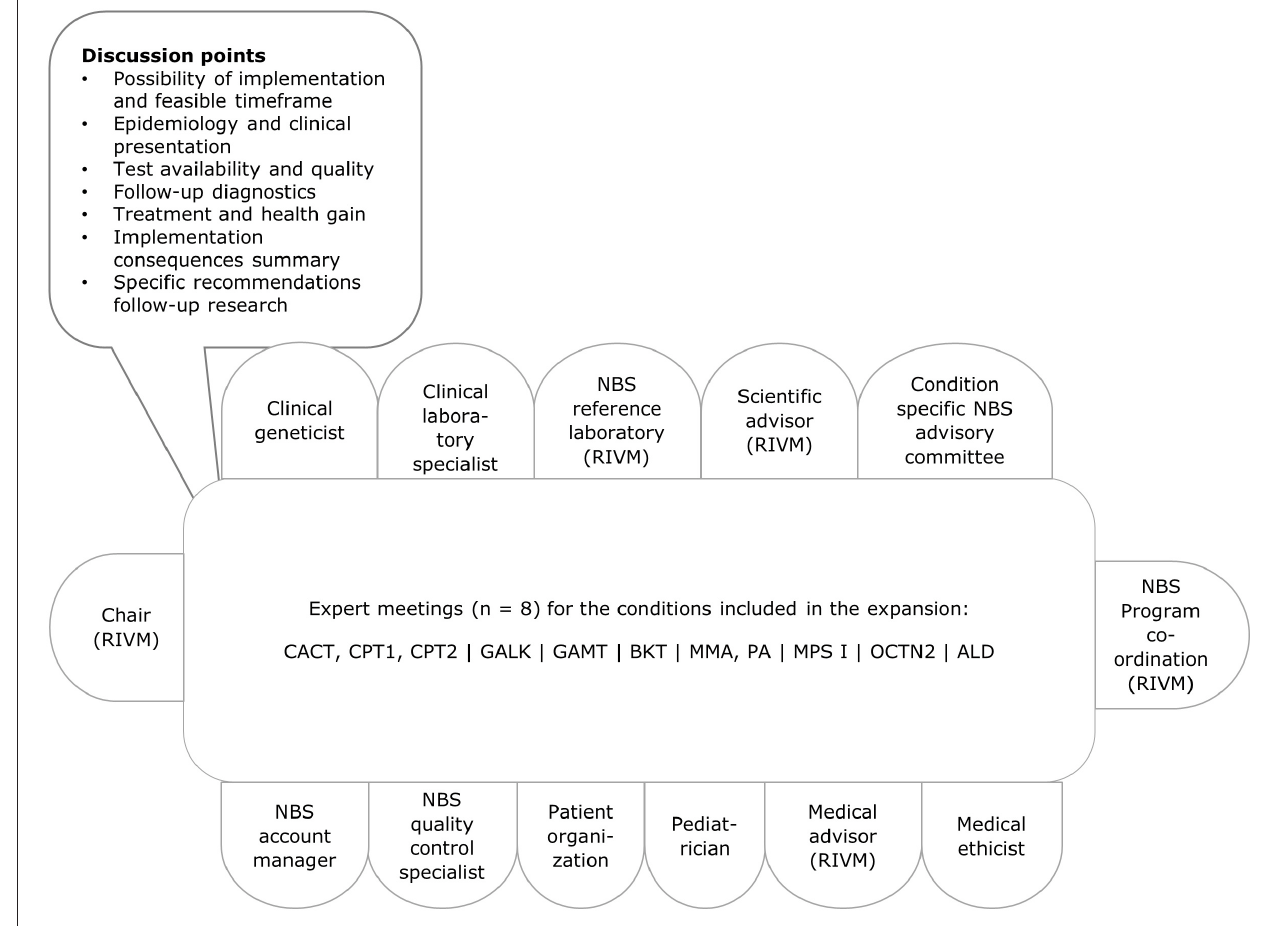
FIGURE 2 | Stakeholders involved and agenda with discussion points. Per condition relevant changes were made to the composition of the group, for example including a metabolic paediatrician or a neuromuscular paediatrician. ALD, X-linked adrenoleukodystrophy; BKT, methyl-acetoacetyl-CoA thiolase deficiency, ketothiolase deficiency; CACT, carnitine-acylcarnitine translocase deficiency; CPT1, carnitine palmitoyltransferase deficiency type 1; CPT2, carnitine palmitoyltransferase deficiency type 2; GALK, galactokinase deficiency; GAMT, guanidinoacetate methyltransferase deficiency; MMA, methylmalonic acidemia; MPS I, mucopolysaccharidosis type 1; PA, propionic acidemia; OCTN2, organic cation transporter 2 deficiency; RIVM, National Institute for Public Health and the